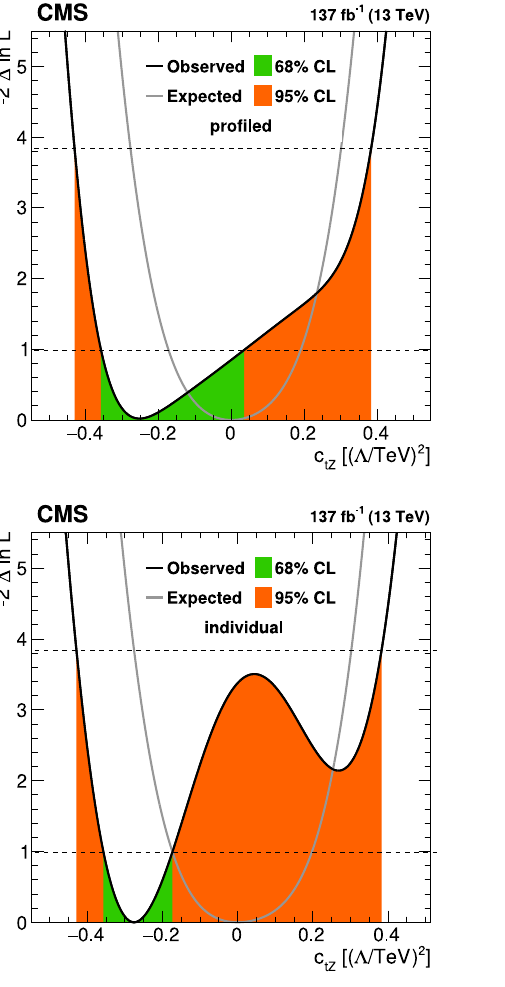
Figure 12 . Results of the one-dimensional scans of the Wilson coefficients c In the upper row, the other Wilson coefficient is profiled, while in the lower row it is set to zero. The green and orange bands indicate the 68 and 95% CL contours on the Wilson coefficients,